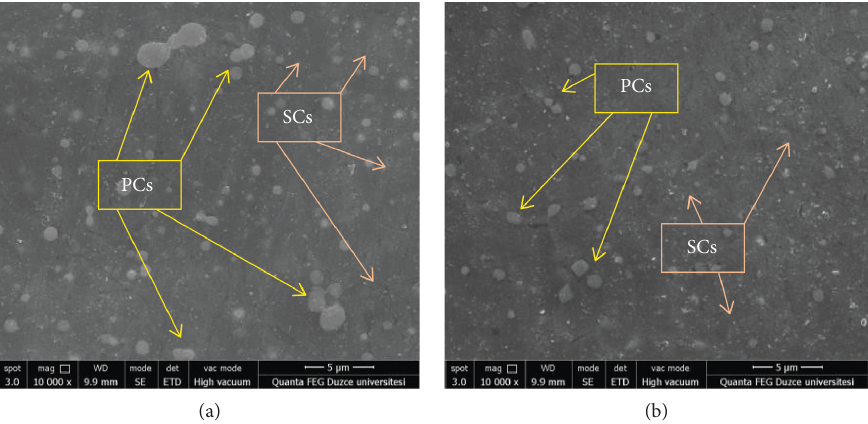
Figure 6: Microstructure of AISI M2 samples. (a) HT. (b) CT.